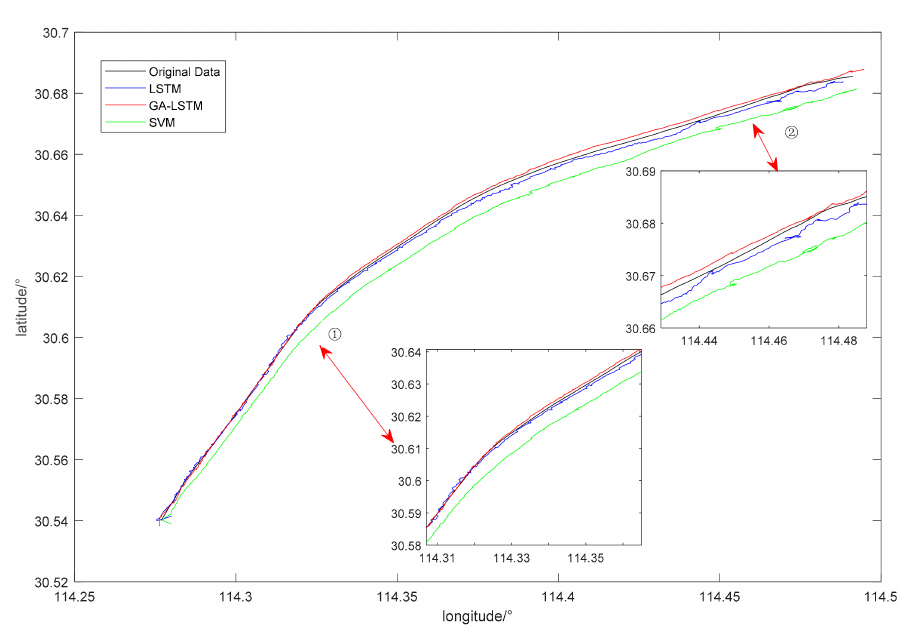
Figure 10. Comparison of experimental results of ship-2 trajectory